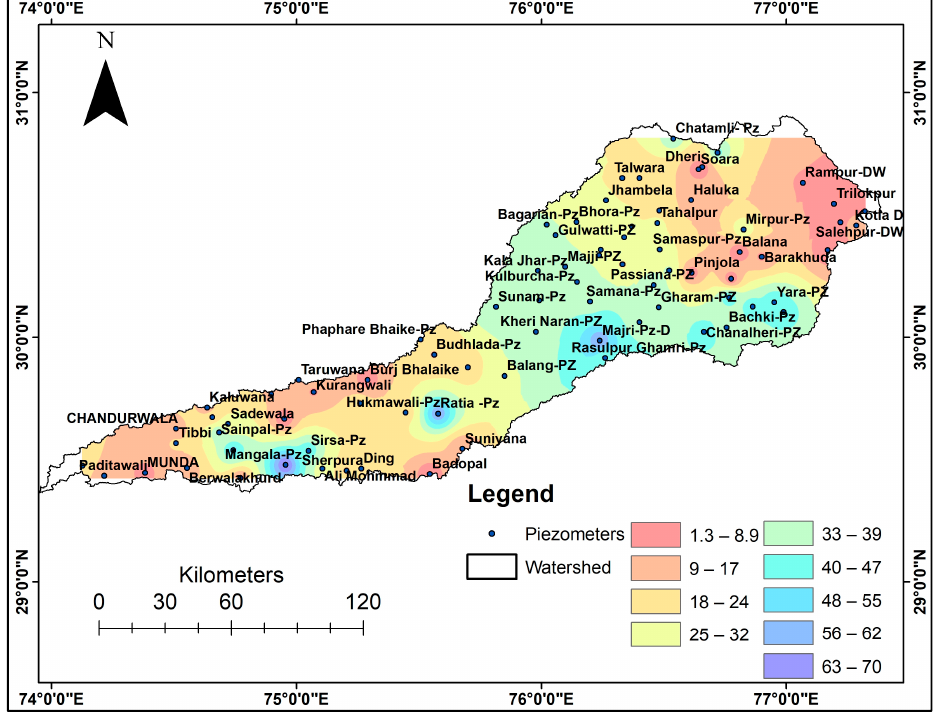
Figure 17. Interpolated groundwater level